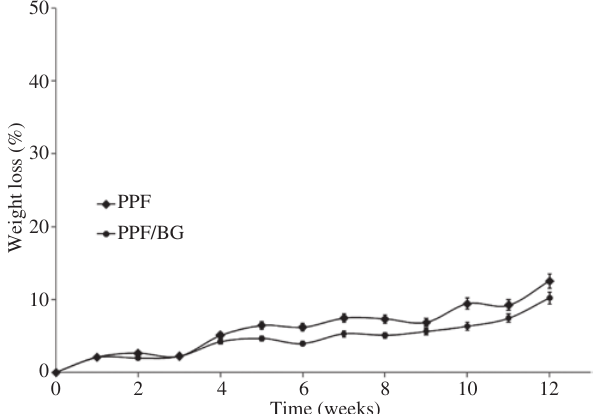
Figure 8 Normalized mass of PPF and PPF/BG scaffolds as a function of time.